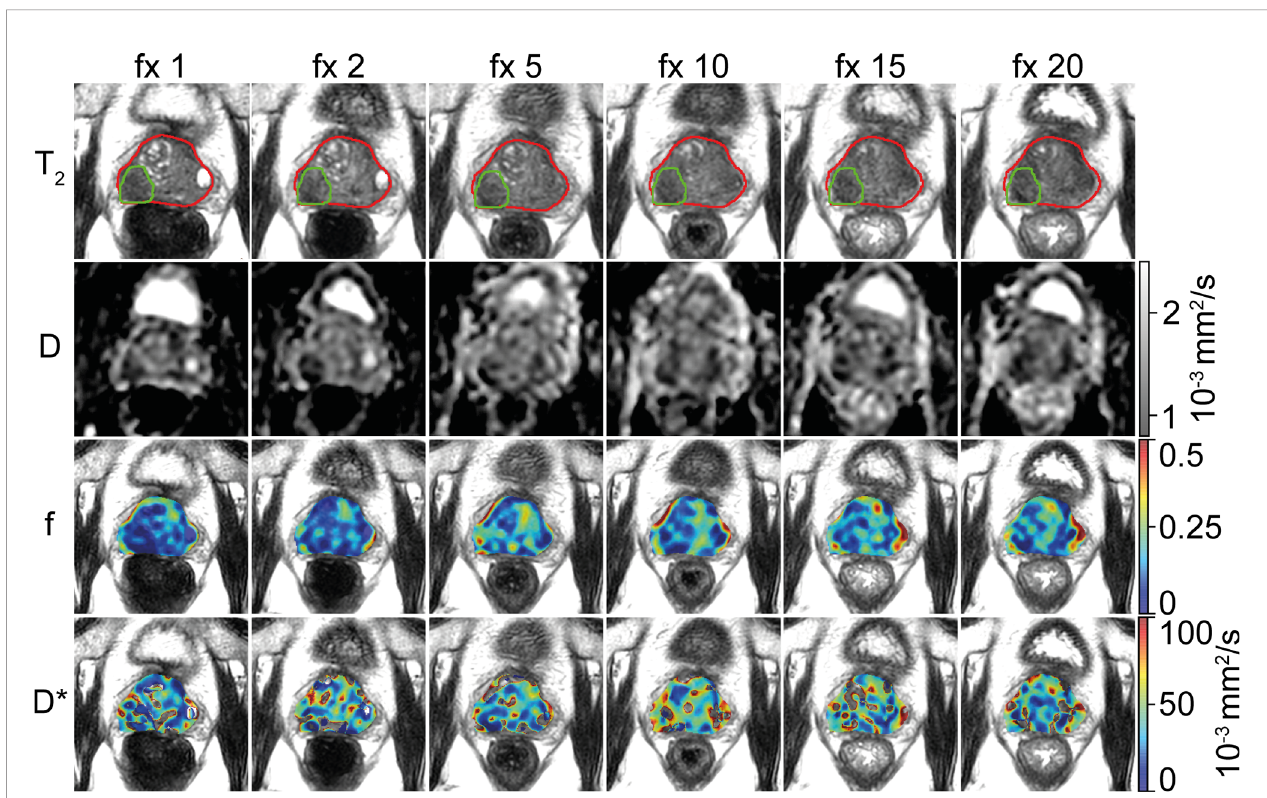
FIGURE 1 | Example of a prostate cancer patient. A voxel-wise map of the IVIM parameters is shown for six treatment fractions (fractions 1, 2, 5, 10, 15, and 20). The prostate is delineated in red, and the tumor is delineated in green. The images are resampled to the reconstructed voxel sizes of the T 2 -weighted acquisition (0.6 × 0.6 × 1.2 mm 3 ). Note that during analysis, the voxels from inside the tumor delineation were excluded from the prostate delineation to create the non- cancerous